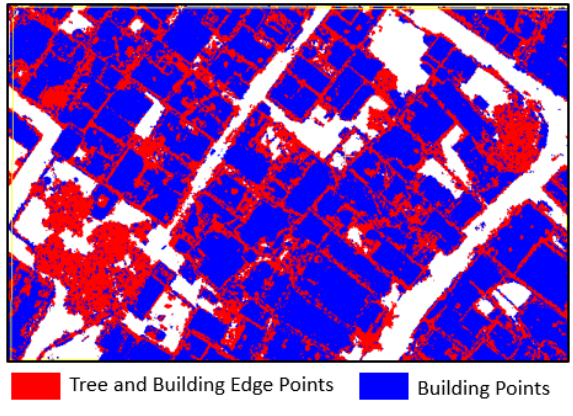
Figure 6: Trees and Building points